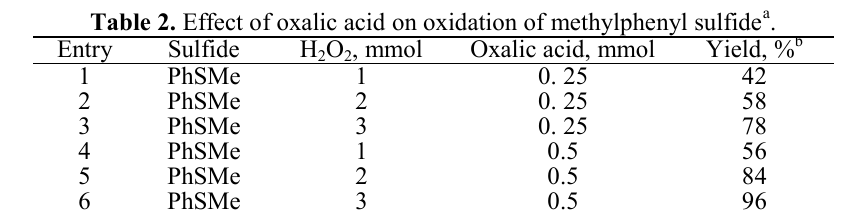
Table 2. Effect of oxalic acid on oxidation of methylphenyl sulfide a .